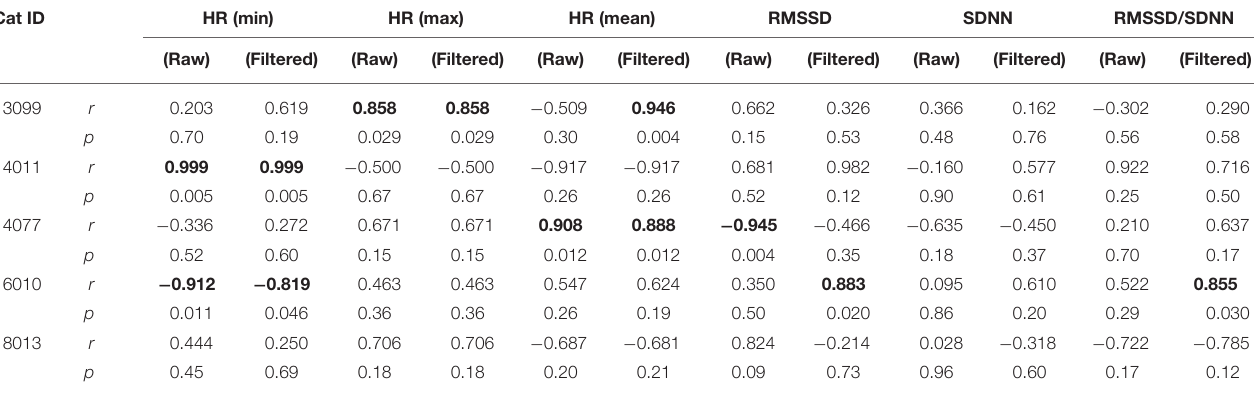
TABLE 2 | Correlations between Polar H10 data (raw data, and data filtered using outlier removal methods described in the text) and the ambulatory ECG (Holter) data for all cardiac parameters and all cats used for data